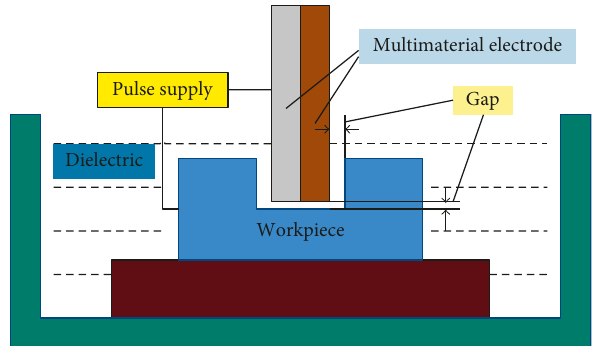
Figure 1: Machining process of EDM with multimaterial